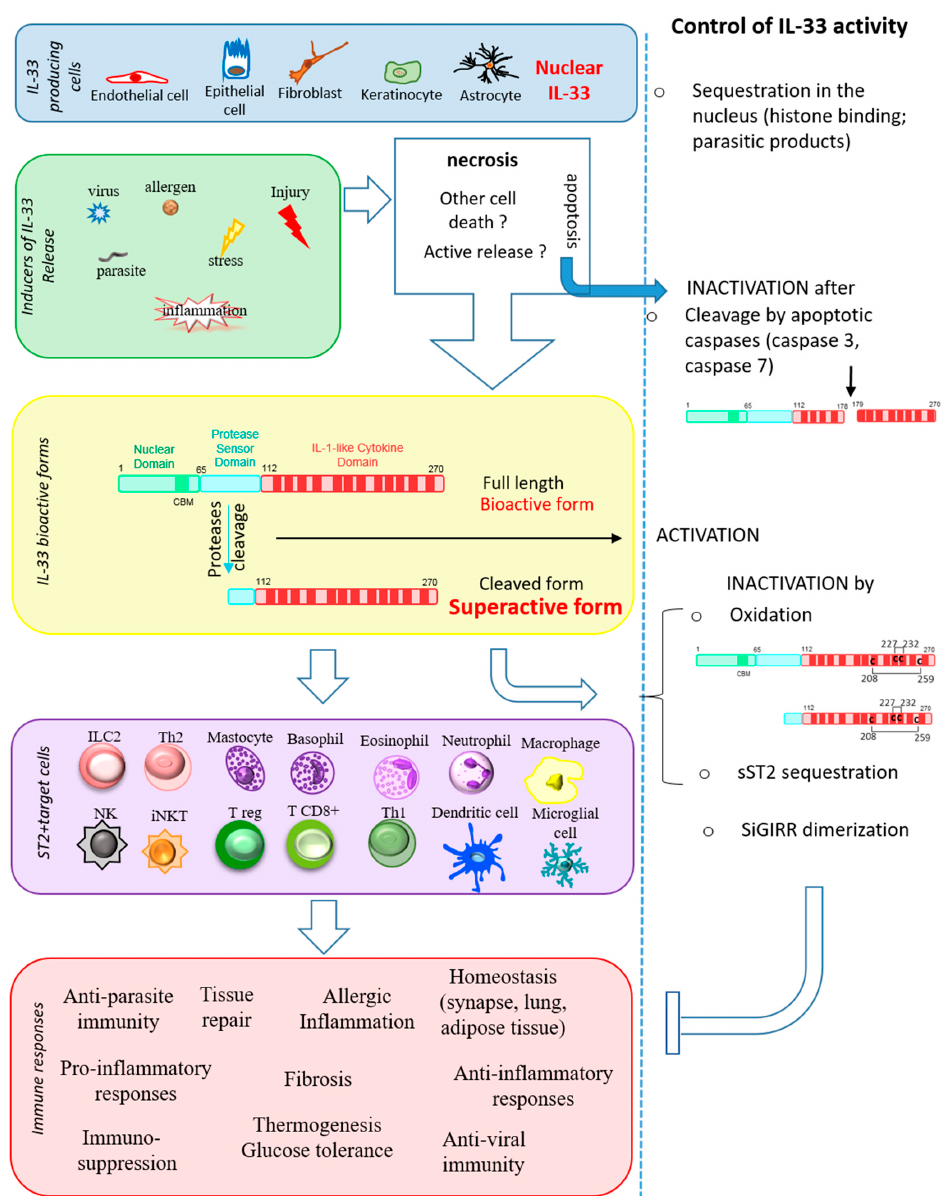
Figure 1. Mechanisms regulating IL ‐ 33 bioactivity. The figure shows IL ‐ 33 producing cells, inducers of IL ‐ 33 release, IL ‐ 33 bioactive forms, ST2 + target cells implicated in type 1 and type 2 immune responses ( left panels) and the mechanisms regulating IL ‐ 33 activity ( right panels).